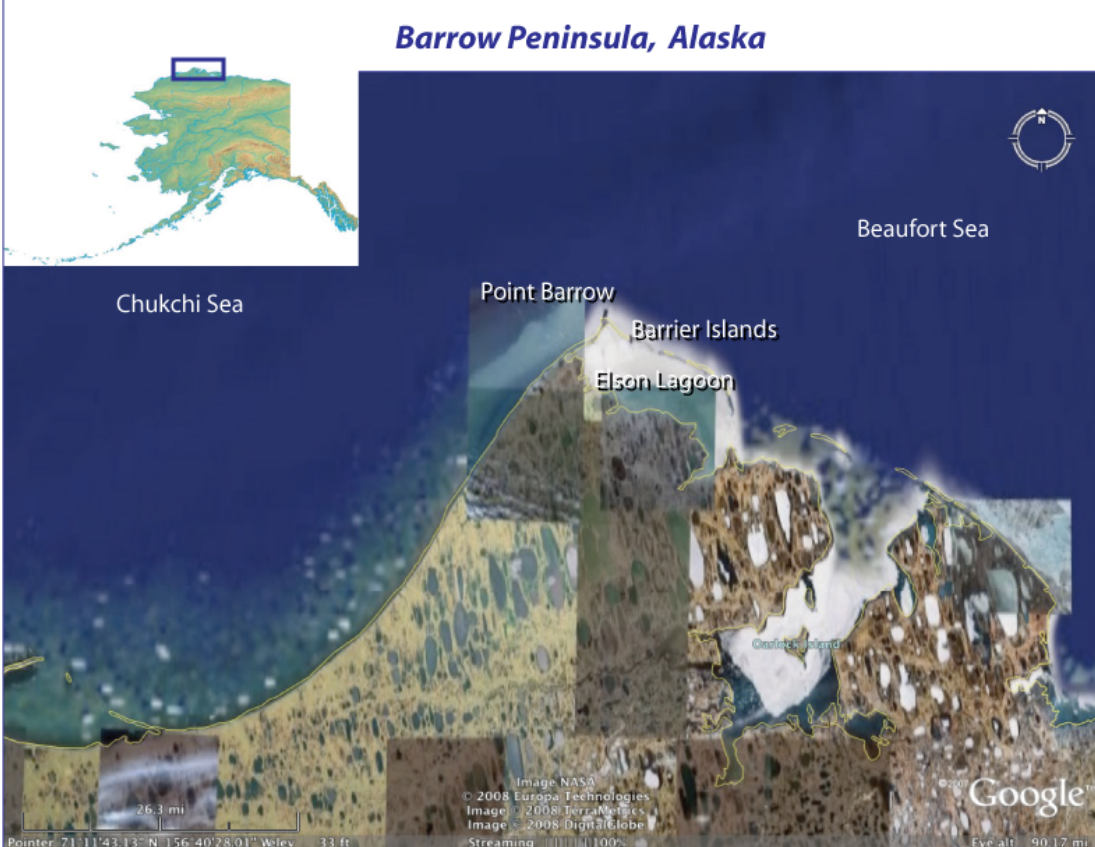
Figure 2. Study areas and surroundings near Point Barrow, Alaska. The Point Barrow area includes sea ice in three different environments in the Chukchi Sea, the Beaufort Sea and Elson Lagoon. The northernmost point of the spit, Point Barrow, indicates the latitude that separates the Chukchi Sea from the Beaufort Sea. From the end of the spit extends a line of barrier islands, which separates the protected waters of Elson Lagoon from the open waters of the Beaufort Sea. Inset: Location of study area in northern Alaska. Image base from Google